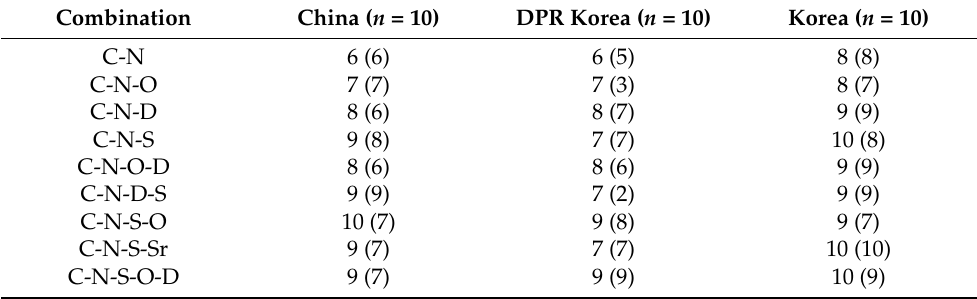
Table 3. Numbers of individuals with geographical origins defined by LDA analyses of multi-element combinations. Each number indicates the samples whose origin was well identified out of 10 samples from each country. Numbers in parentheses represent cross-validation results of each geographical origin using leave-one-out cross-validation (LOOCV)